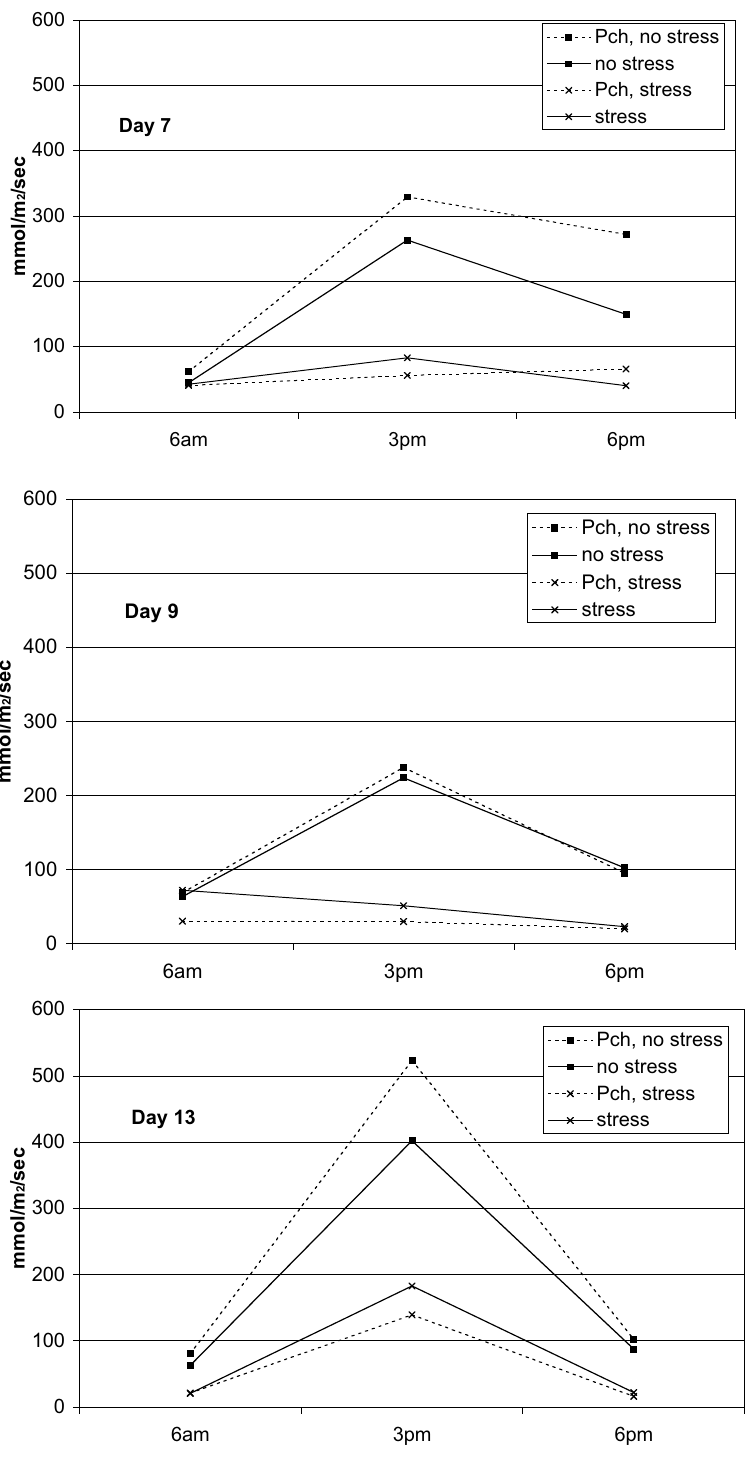
Fig. 6. Zinfandel, Year 2: 2005. Stomatal conductance measured at 6 am, 3 pm and 6 pm on days 7, 9 and 13 after stress treatments